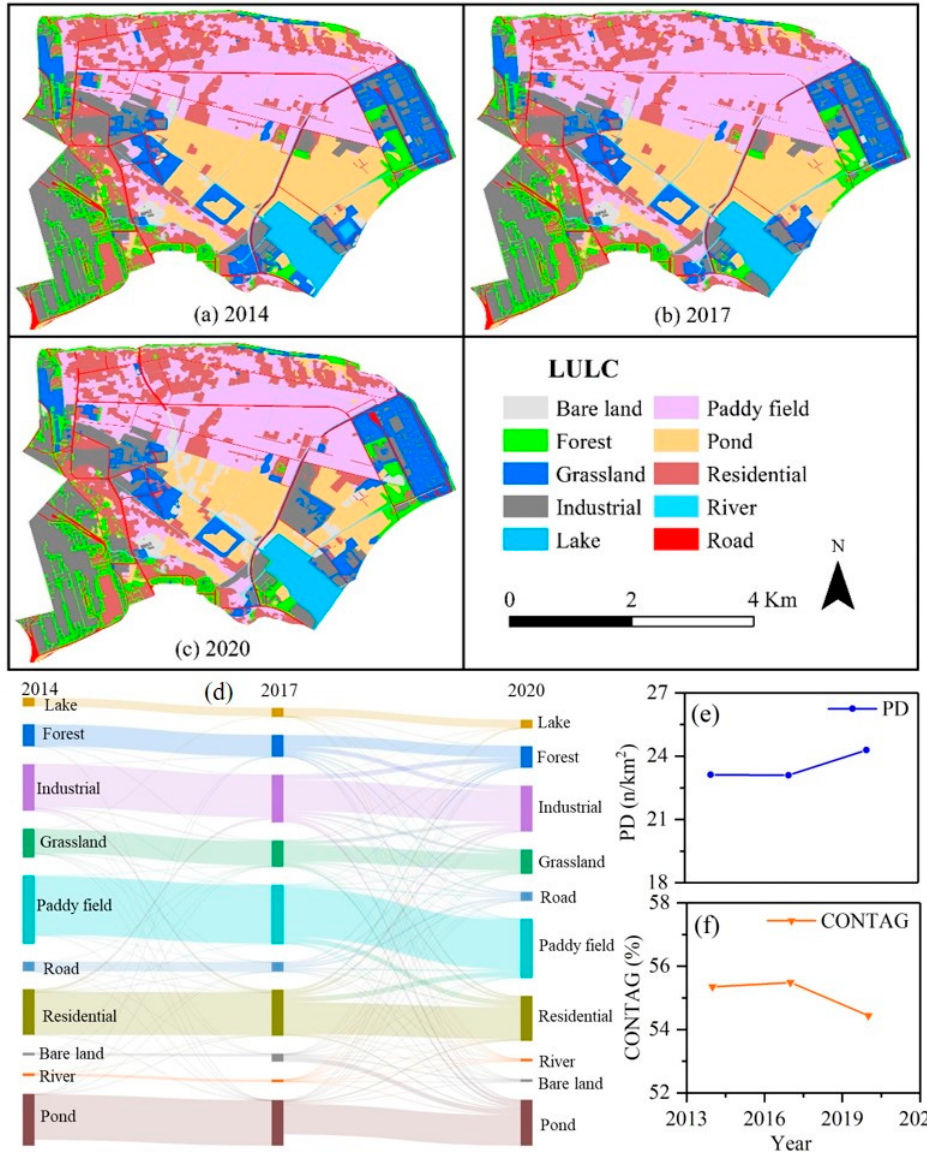
Figure 3. Land use and land change ( a – d ); land metrics ( e , f ).